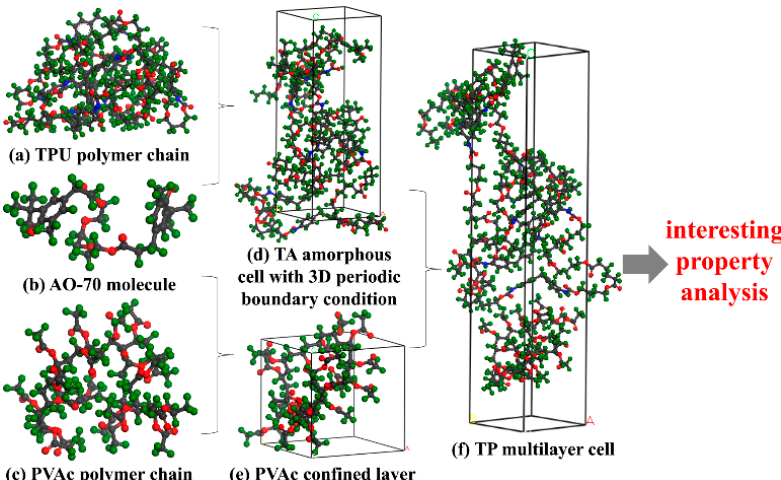
Figure 2. Models for molecular dynamics (MD) simulation of the multilayer composites (red atom is O, green atom is H, grey atom is C and blue atom is N). ( a ) TPU polymer chain; ( b ) AO-70 molecule; ( c ) PVAc polymer chain; ( d ) TA amorphous cell with 3D periodic boundary condition; ( e ) PVAc confined layer; ( f ) TP multilayer cell.